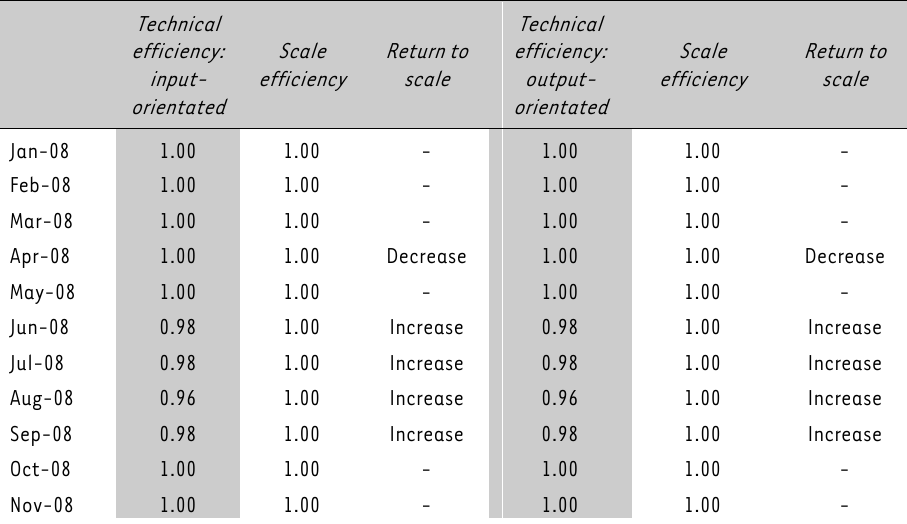
TABLE 17: Efficiency estimates: FirstRand